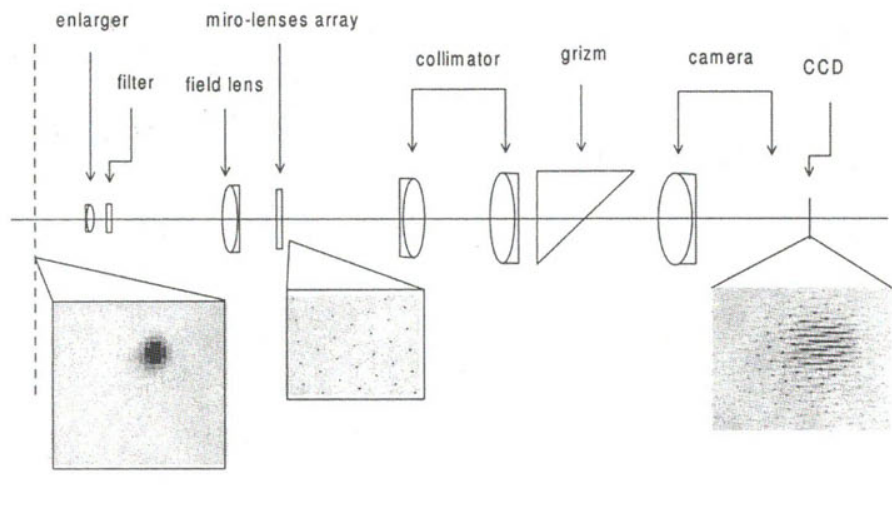
Fig. 1. Optical scheme of the spectrograph "Vagr".